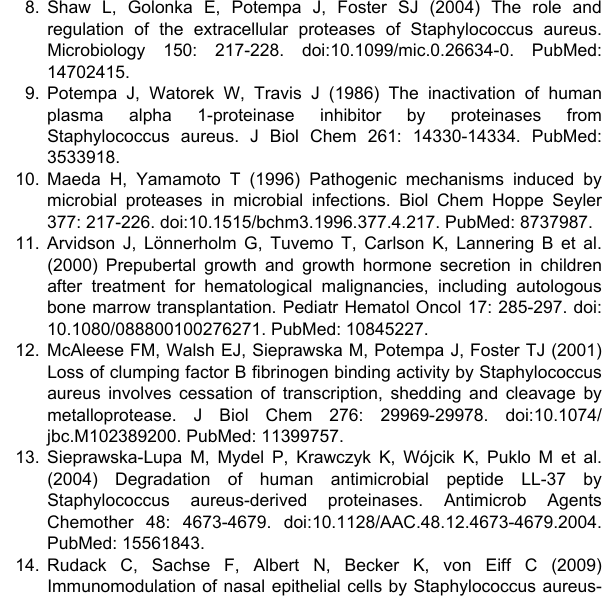
File S1. Figure S1 , Overall fold of SplD protease. Figure S2 , Interpretation of the orientation of the sidechain of catalytic triad Ser156 in the crystal structure of SplD. Figure S3 , Comparison of substrate specificities of SplD and HNE proteases. Figure S4 , Disposition of the N-terminal glutamic acid residue in the structures of SplA, SplB and GS-SplD proteases. Note S1 , Ambiguity of P(n) and P(n)’ subsite specificity determination in fluorescence quenched LSTS assay. Note S2 , Conformation of the catalytic triad serine in the crystal structure of SplD protease. Table S1 , synthetic substrates tested for hydrolysis by SplD protease. Table S2 , SplD substrate specificity determined using CLIPS. Table S3 , Average main chain angles of the residues forming the oxyanion hole. Table S4 , Predictions of the in silico model of SplD interaction with consensus substrate. Table S5 , Potential physiological substrates of SplD